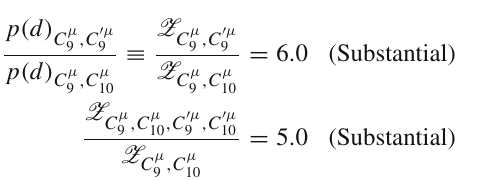
μ (cid:4) μ , C (fourth row of Table 9 9